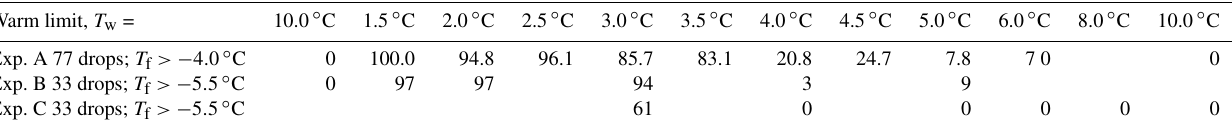
Table 2. Percentage of drops with T f > − 4 . 0 ◦ C in Exp. A and T f > − 5 . 5 ◦ C in Exps. B and C after melting at different warm limits. There are large decreases in the percentages frozen for T w > − 3 . 5 ◦ C, but non-zero values extend to warm limits well above that value. Warm limit, T w =